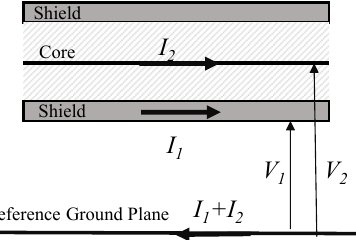
FIGURE 3. Coaxial cable: single-reference